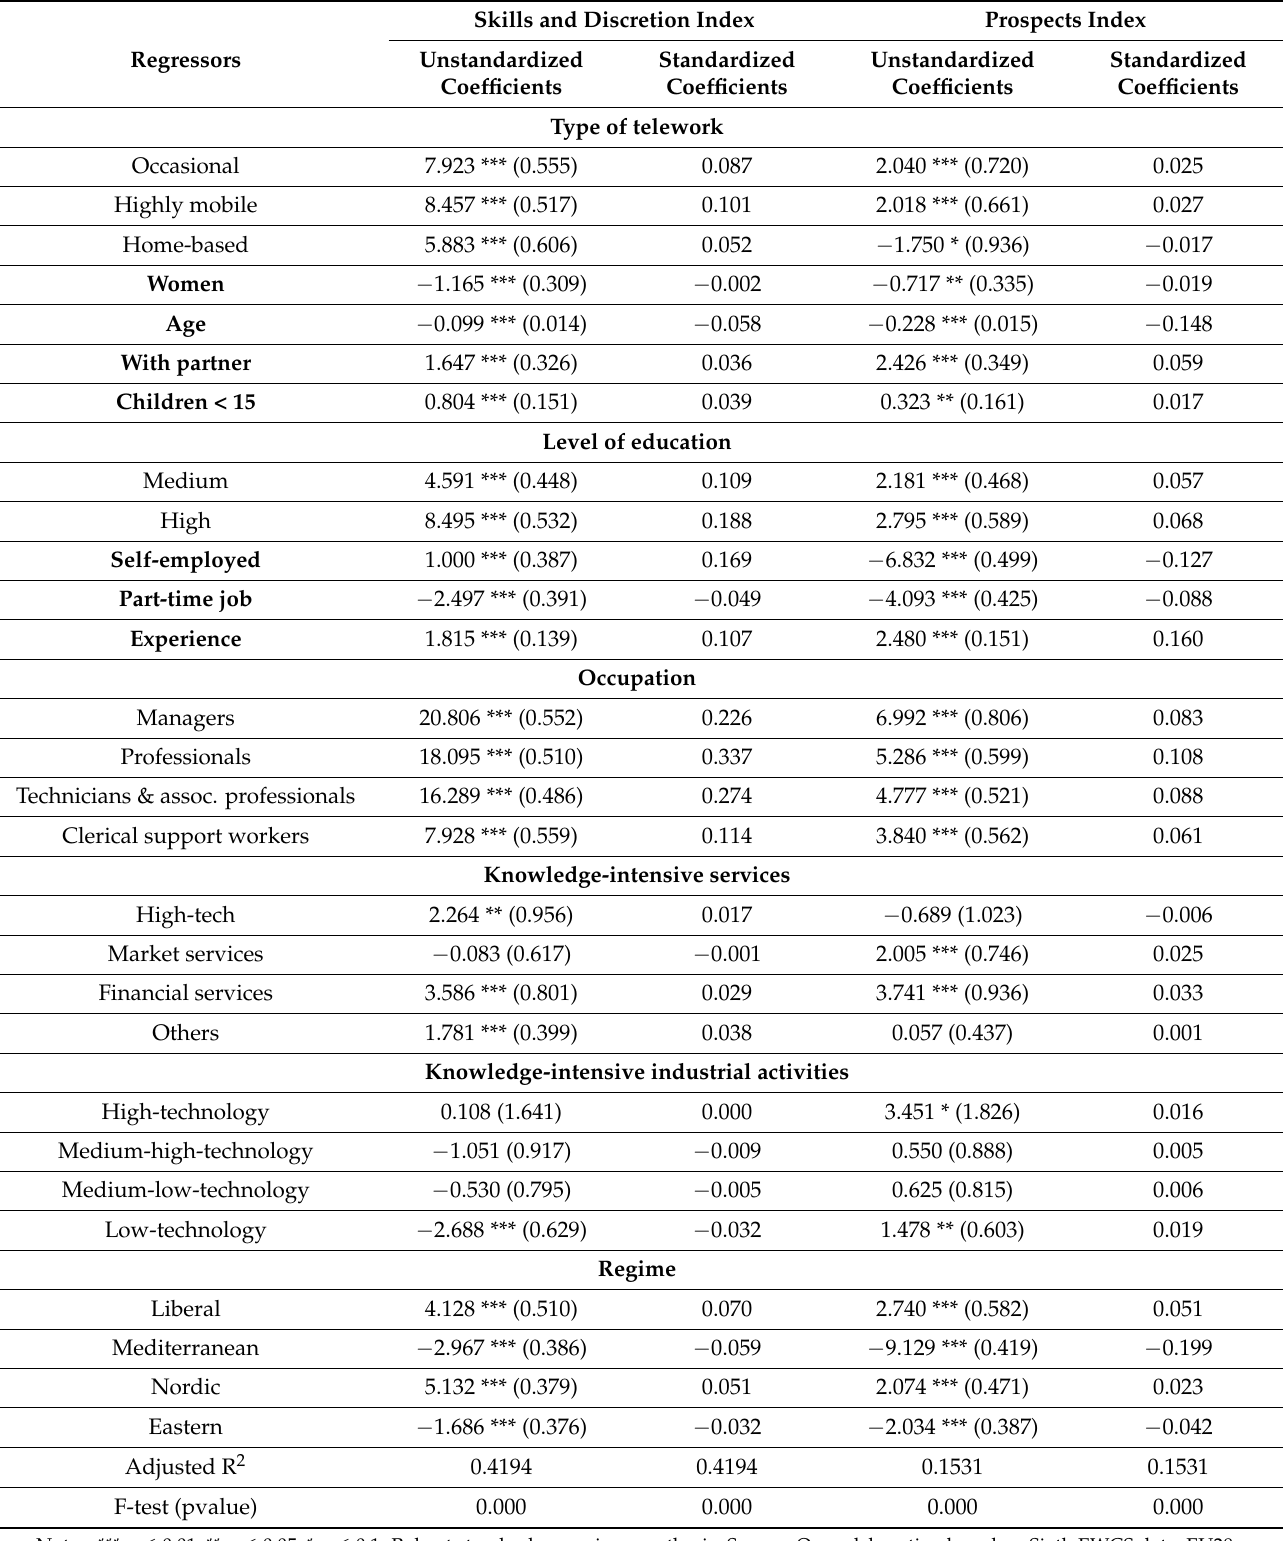
Table 1. Ordinary Least Squares regression